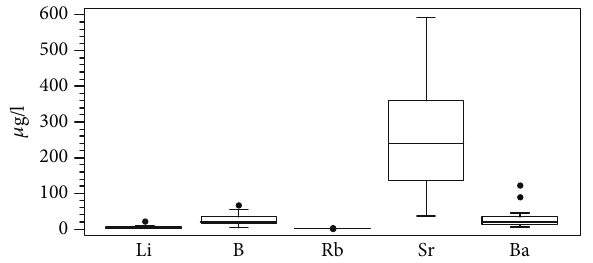
Figure 4: Box-and-whisker plot of selected trace